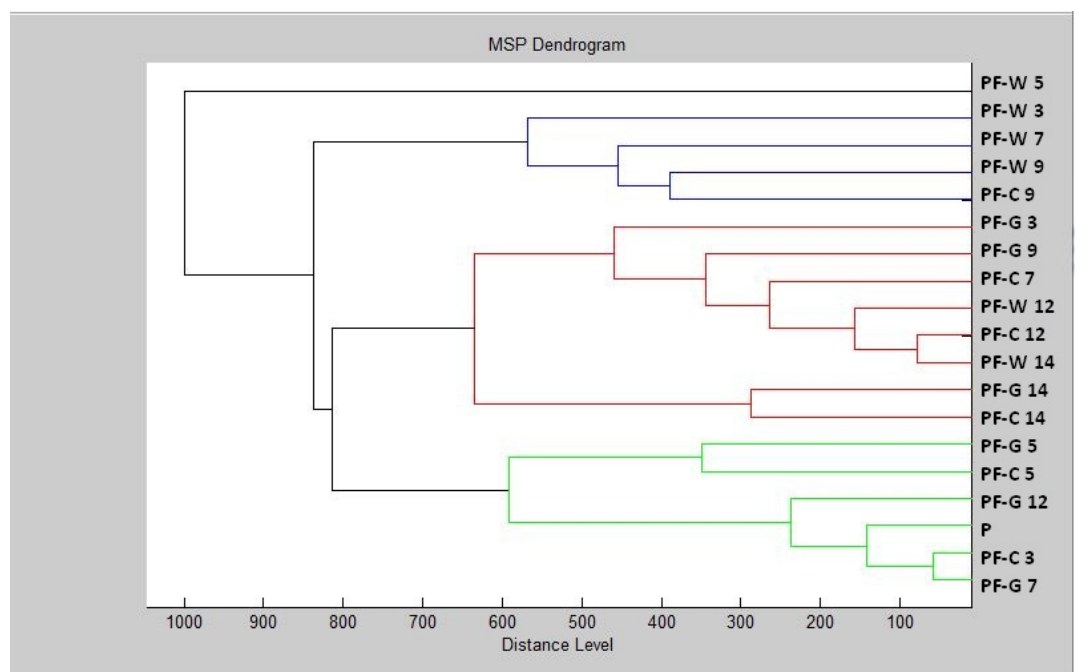
Figure 2. Dendrogram of P. fluorescens biofilm progress after TTEO exposition. PF— P. fluorescens ; C—control; G—glass; W—wood; P—planktonic cells.